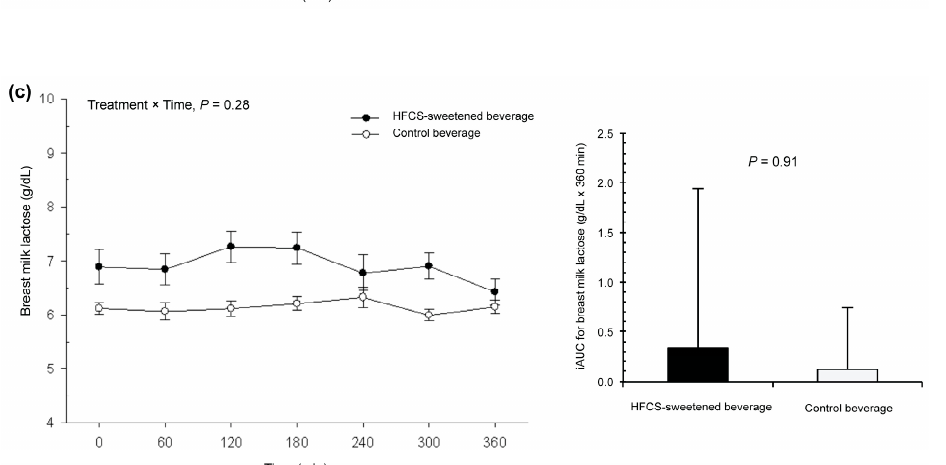
Figure 2. Breast milk concentrations of ( a ) fructose, ( b ) glucose, and ( c ) lactose in 41 lactating women after consumption of a HFCS-sweetened beverage or control beverage. Values are mean ± SEM. HFCS, high-fructose corn syrup; iAUC, incremental area under curve; SEM, standard error of mean.